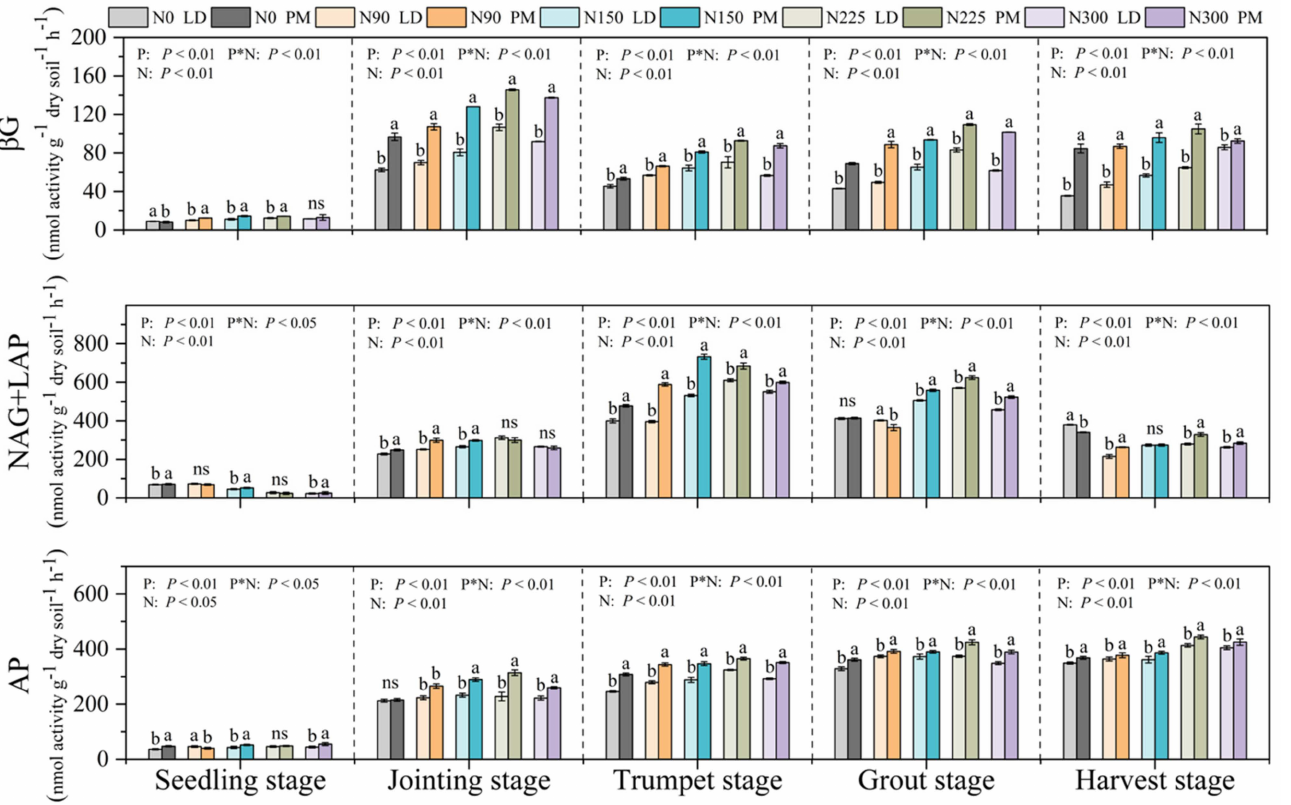
Figure 2. Soil enzyme activities under different treatments. P, plastic film mulching; N, nitrogen levels; P*N, plastic film mulching * nitrogen levels; N0, nitrogen application level was 0 kg · hm − 2 ; N90, nitrogen application level was 90 kg · hm − 2 ; N150, nitrogen application level was 150 kg · hm − 2 ; N225, nitrogen application level was 225 kg · hm − 2 ; N300, nitrogen application level was 300 kg · hm − 2 . Different lowercase letters (a, b) indicate that there was a significant difference between the PM and LD treatments at the same nitrogen level, and “ns” indicates that there was no significant difference between the PM and LD treatments at the same nitrogen